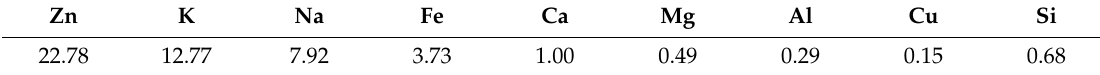
Table 5. Composition and content of RHF secondary dust (wt%).